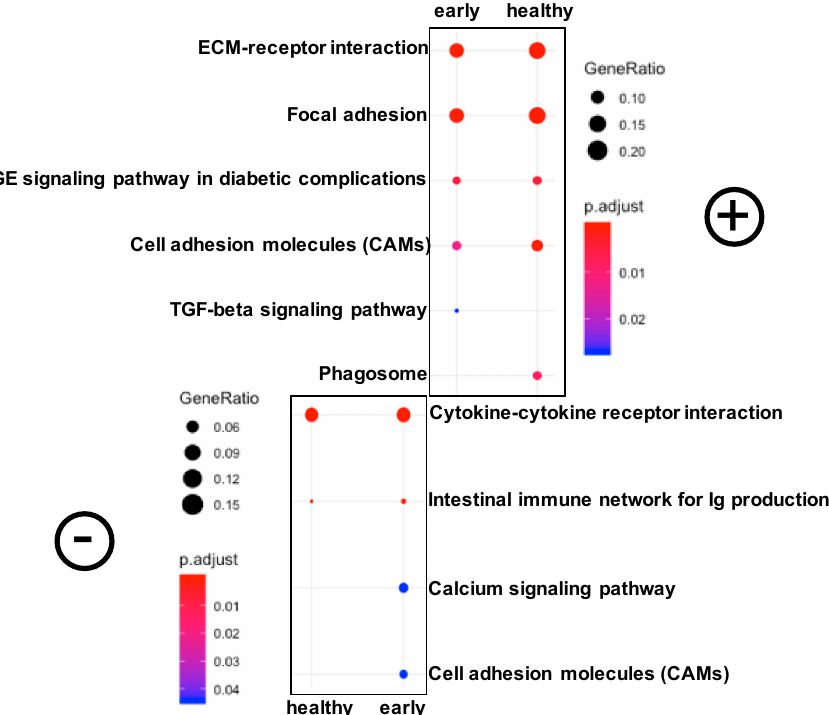
Figure 4. A representation of significantly differentially expressed pathways in the skin of fish at the late stage of the disease compared to both healthy and early conditions using clusterProfiler. Symbols were used to designate upregulated (+) and downregulated (–) pathways.